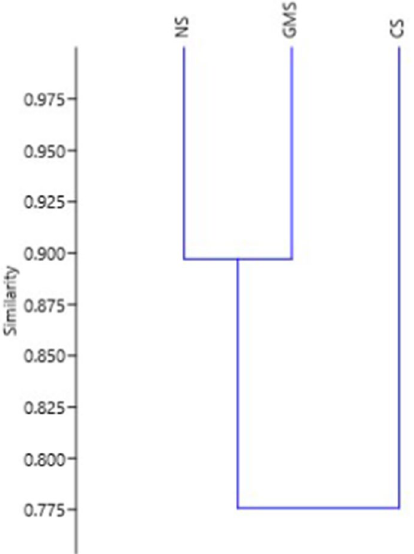
Fig. 4 Dendrogram showing similarity between sites based on the abundance of prawns